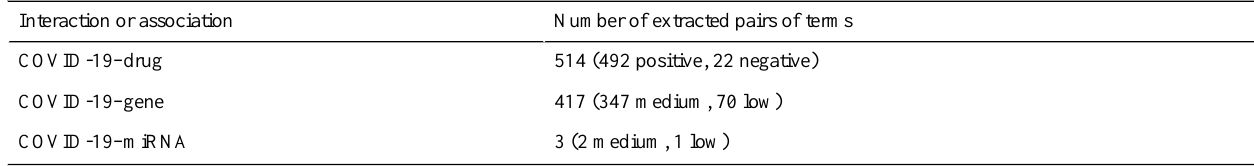
Table 2. Biomedical terms that are related to COVID-19 a .